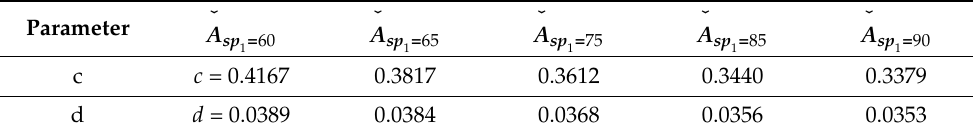
parameters’ values (procedure 2). 1